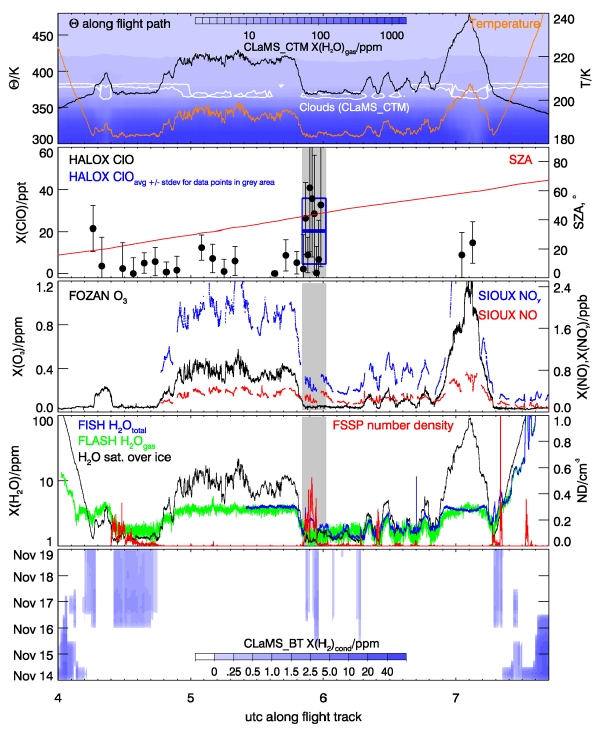
Fig. 6. Observations made during the SCOUT-O 3 flight on 19 November 2005 from Darwin (see text for details). Also shown in the top panel are CLaMS CTM simulations of X (H 2 O) around the Geophysica flight track with white contours indicating the pre- dicted occurrence of cirrus clouds. The bottom panel shows CLaMS X (H 2 O) cond along 5-day backtrajectories ending on the flight